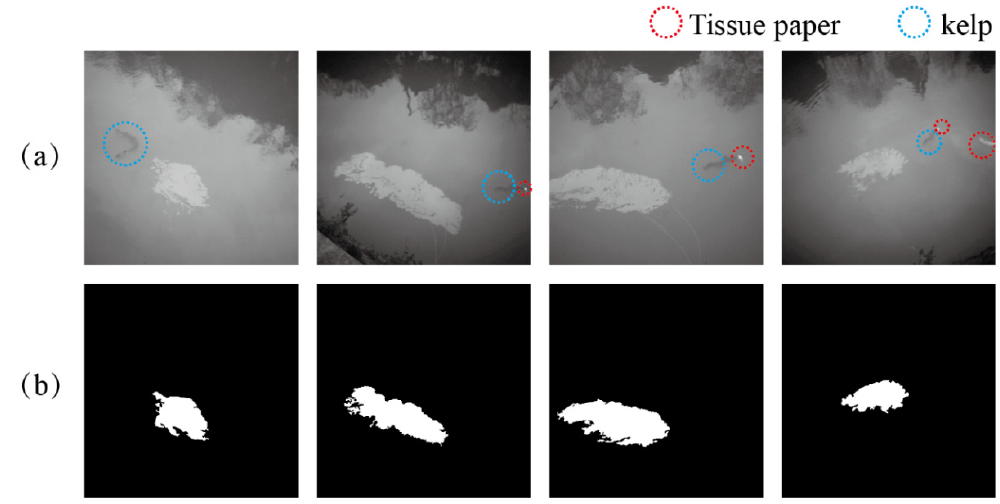
Figure 13. Segmentation result of UV images containing interferents. ( a ) Original UV images and ( b ) results using our method.